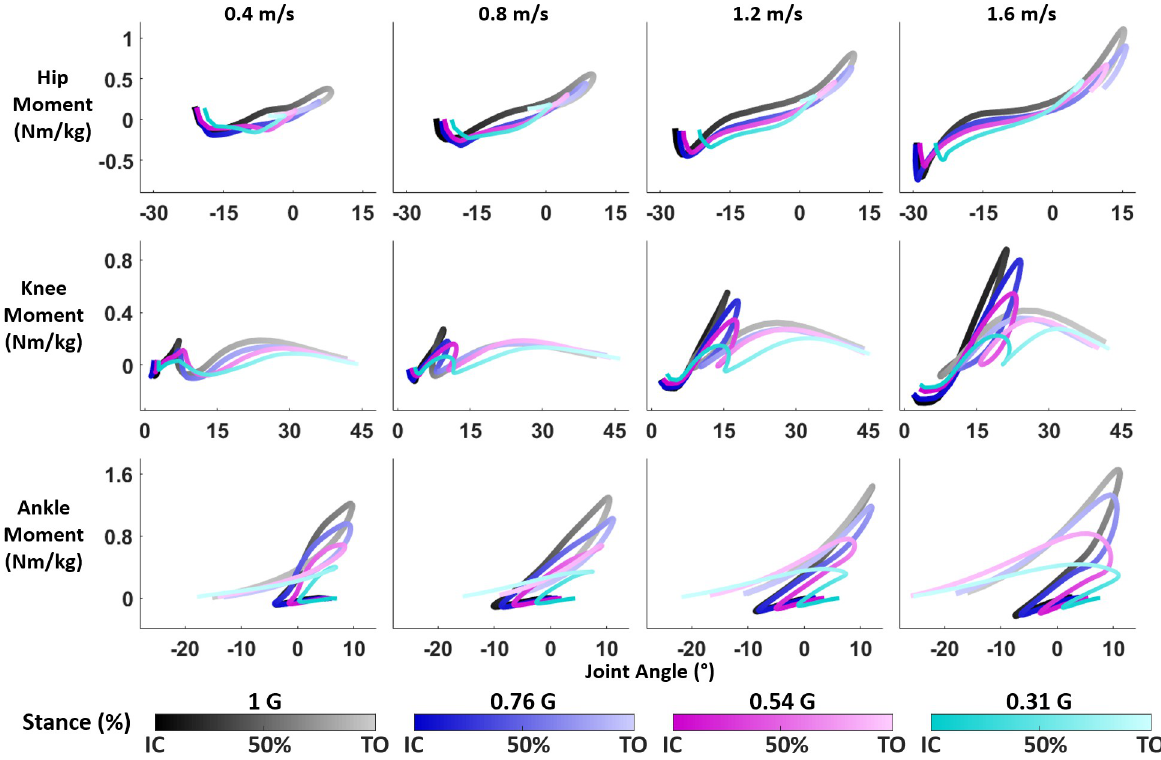
Fig 4. Moment-angle loops in stance phase for the hip, knee, and ankle walking in 1, 0.76, 0.54, and 0.31 G at 0.4, 0.8, 1.2, and 1.6 m/s. Data for visualization were normalized to 60 data points and averaged across all participants in each condition. Every x-axis displays joint angle of the respective